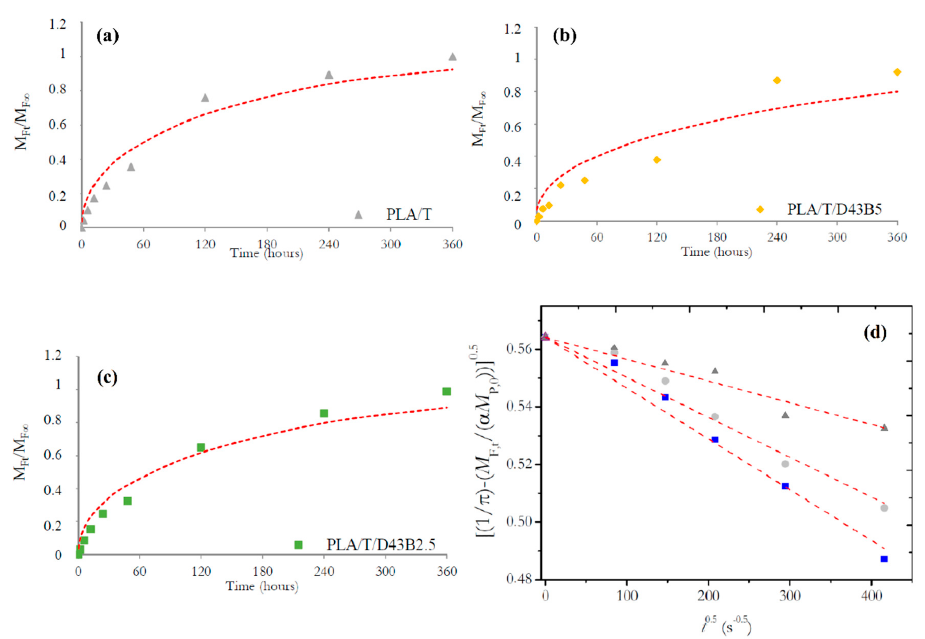
Figure 1. Normalized release of thymol from di ff erent polymer matrices: ( a ) PLA / T, ( b ) PLA / T / D43B2.5, (cid:104) (cid:105) 0.5 − 1 × M F , t 1 and ( c ) PLA / T / D43B5; ( d ) plots of versus t 0.5 for the migration of thymol from: π α M F ,0 PLA / T ( (cid:4) ), PLA / T / D43B2.5 ( • ), and PLA / T / D43B5 ( (cid:78) ), into ethanol 10% ( v / v ). Table 1. Parameters obtained for the release of thymol from PLA-based films into ethanol 10% ( v / v ). PLA / T PLA / T / D43B2.5 PLA / T / D43B5 M P,0 (mg) 16.60 ±